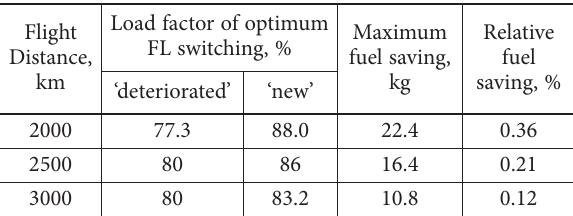
Table 10. Trip fuel in kg, 3000 km flight, ‘Deteriorated’